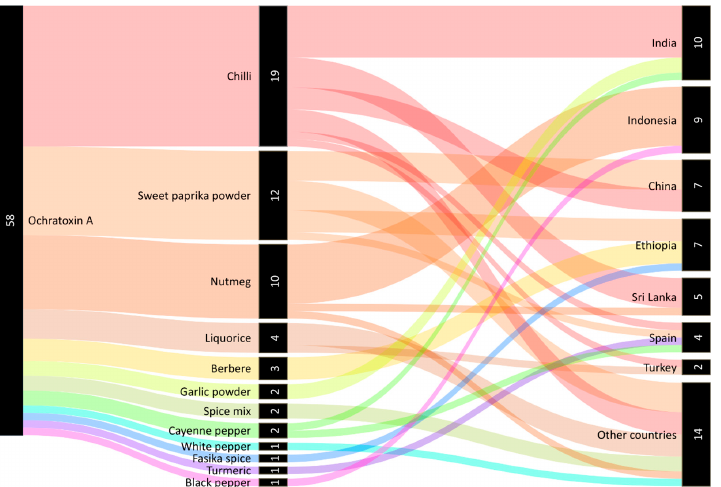
Figure 3. Notifications of ochratoxin A in spices by the Rapid Alert System for Food and Feed (RASFF) since 2016 (current to the 20 July 2021). Notes: The category ‘Other countries’ includes all countries of origin with only one notification for spices: Azerbaijan, Bangladesh, France, Germany, Hungary, Italy, Lebanon, Peru, Portugal, Thailand, Ukraine, the United Kingdom, and Vietnam, or notification of unknown origin. Processed according to the RASFF database [53] using The San- key Diagram Generator online tool and vector graphics editor Inkscape